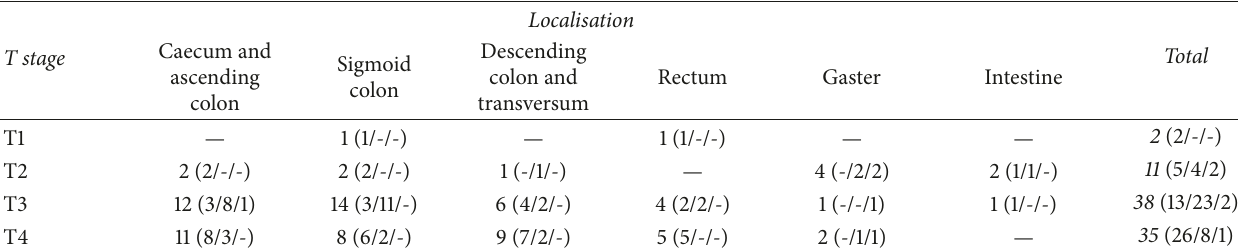
Table2:Tstagedistributionofmalignanttumoursforpatientsinvolvedinthestudy.Bracketscontainnumbersofopensurgeries,laparoscopic surgeries, and robot-assisted surgeries, respectively.